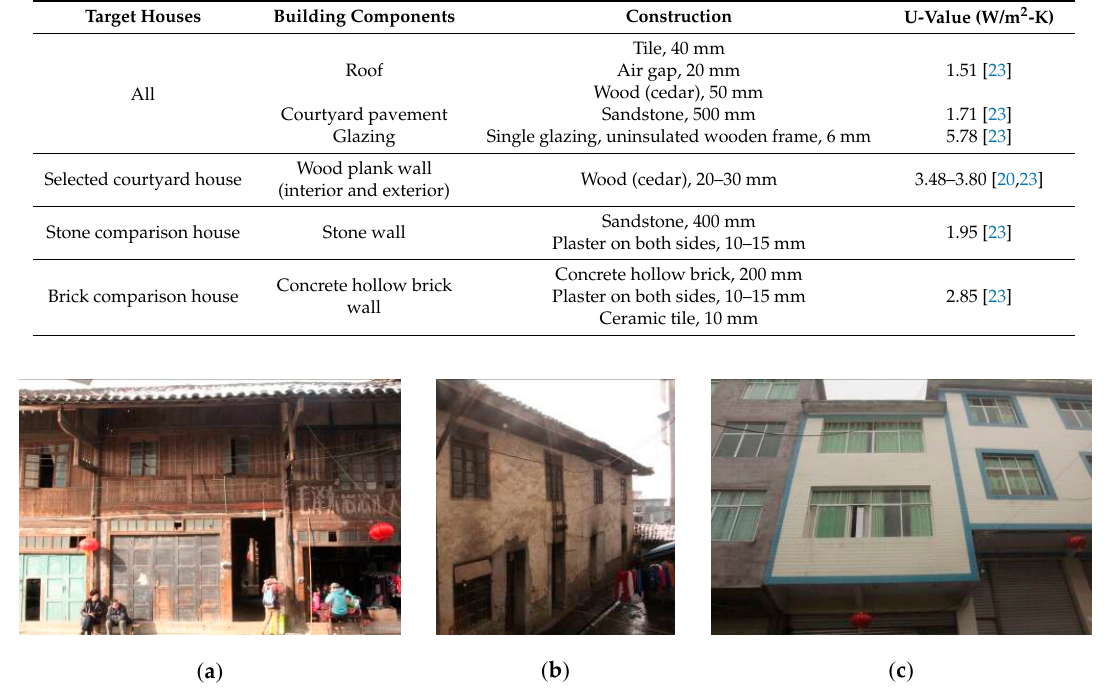
Figure 3. Construction details: ( a ) wood plank walls (from the selected courtyard house), ( b ) tiled roofs (from the selected courtyard house), ( c ) stone walls (from the stone house used for comparison), and ( d ) concrete hollow brick walls (from the brick house used for comparison). Table 1. Materials and Construction Techniques.